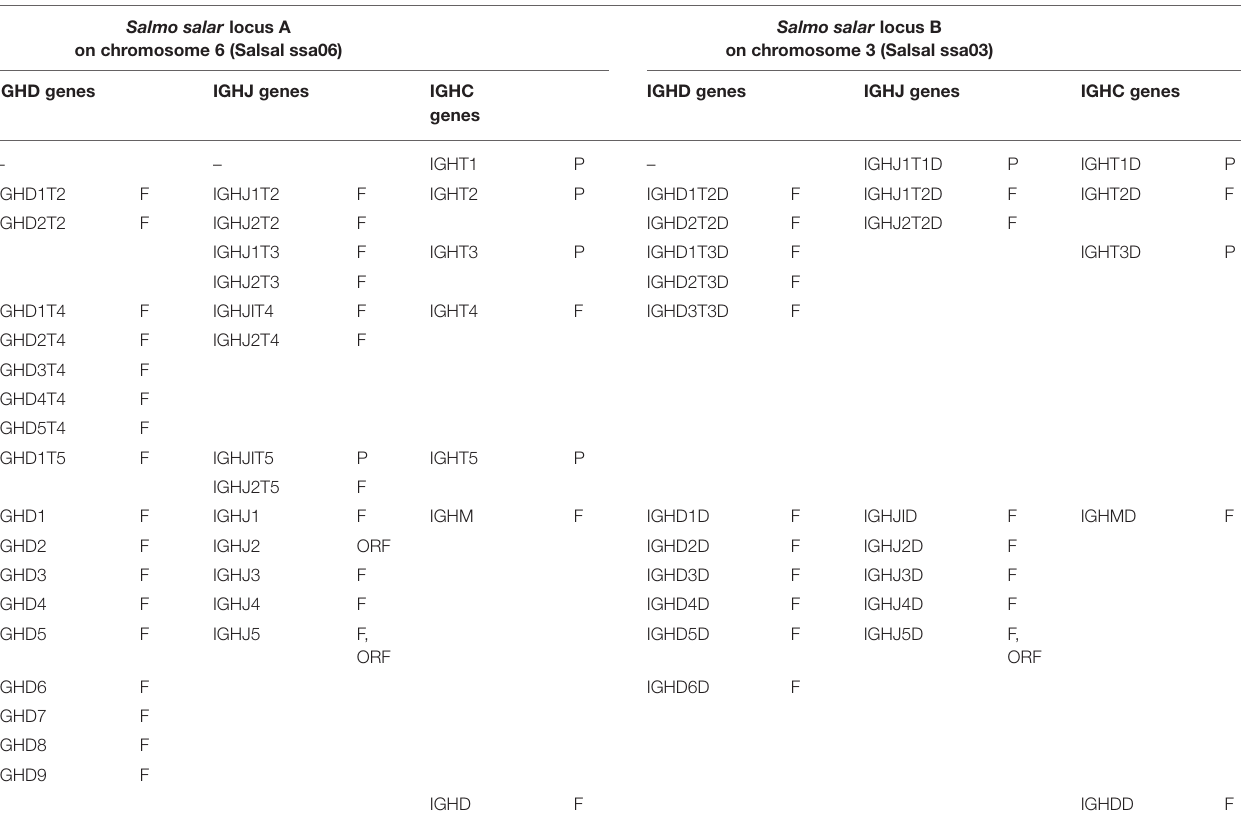
TABLE 2 | Atlantic salmon ( Salmo salar ) IGH constant C genes and associated D and J genes. Salmo salar locus A on chromosome 6 (Salsal ssa06)